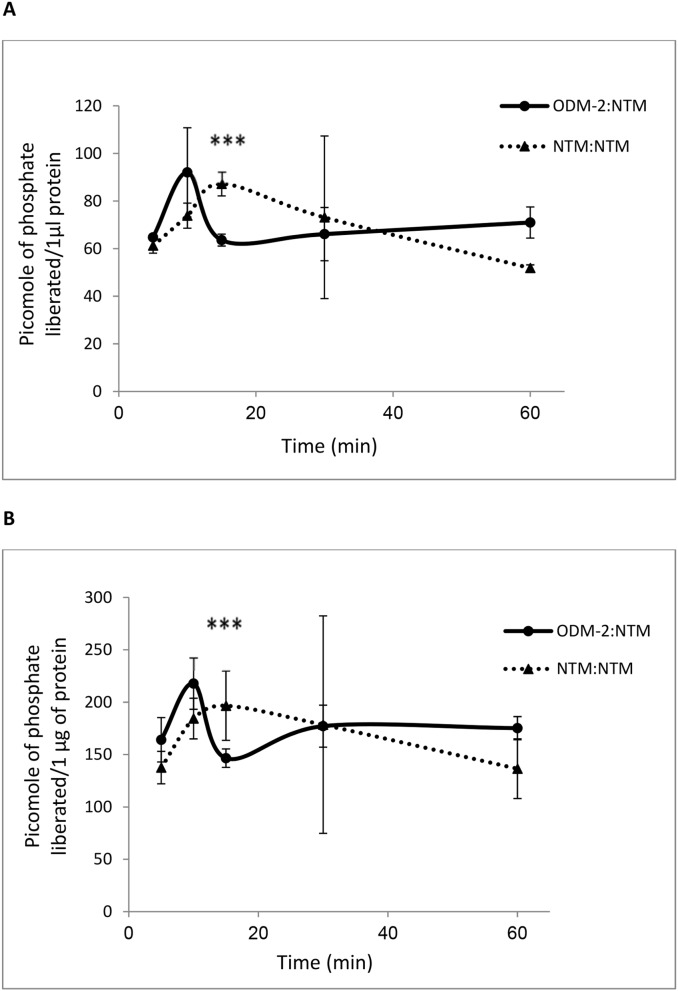
Alkaline and acid phosphatase activity of NTM cells following co-culture with ODM-2 cells for 5, 10, 15, 30 or 60 min.NTM:NTM co-culuure was used as controls. (A) Alkaline phosphatase and (B) acid phosphatase activity determined by the DiFMUP assay. The quantity of DiFMU is expressed as phosphate liberated, since equivalent amounts of DiFMU and phosphate are generated in the reaction. Means of two independent experiments performed in triplicate; one-way ANOVA (***p<0.001).